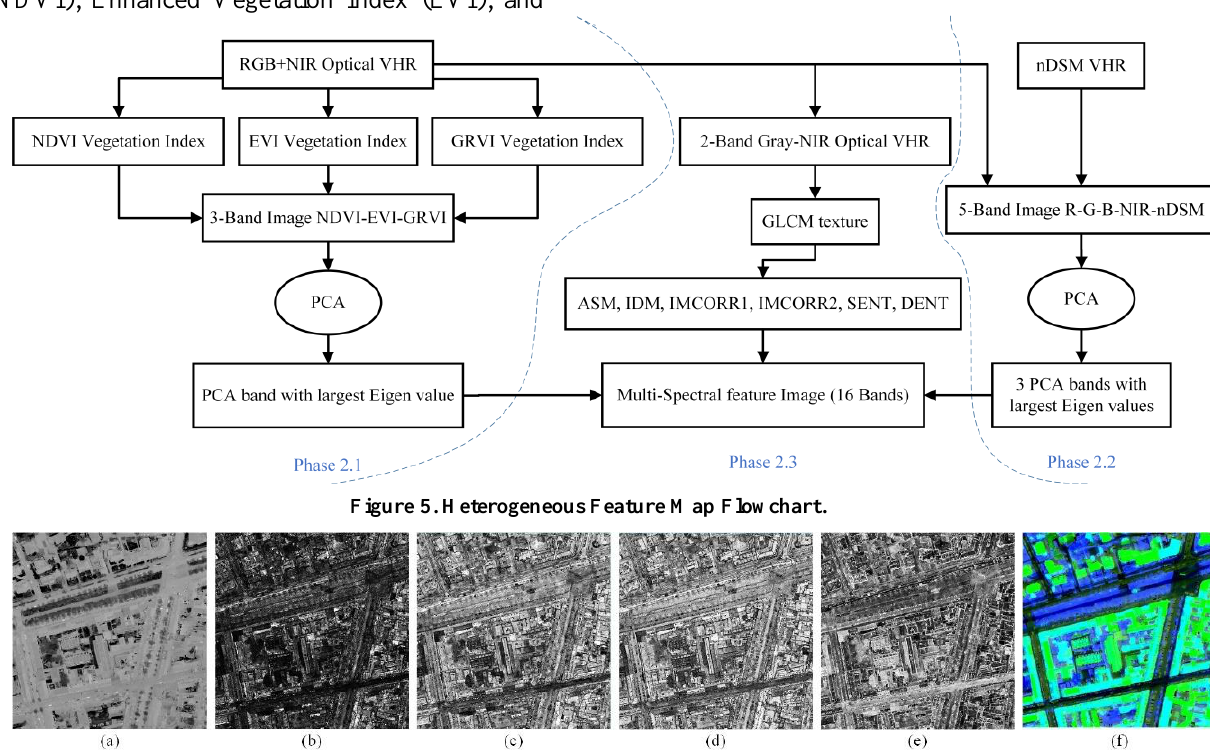
Figure 6. Bands of heterogeneous feature map (a) PC1 of vegetation PCA (b) Gray ASM (c) Gray IDM (d) Gray IMCORR1 (e) Gray DENT (f) Three PCA bands of